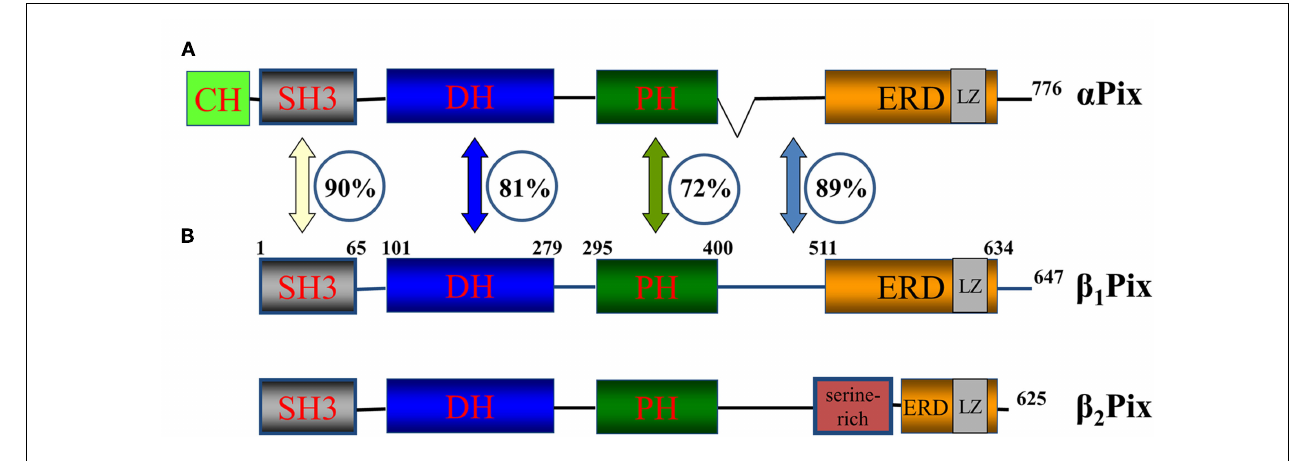
homology.The SH3 domain of β 1 Pix is located between aminoacids (aa) 1 and 65, DBL homology domain between aa 101 and 279 and so on.The numbers in the circles represent the percentage similarity between the domains of two isoforms (Koh et al., 2001).The numbers at the C-terminus corresponds to total number of aa in the corresponding member of the family.